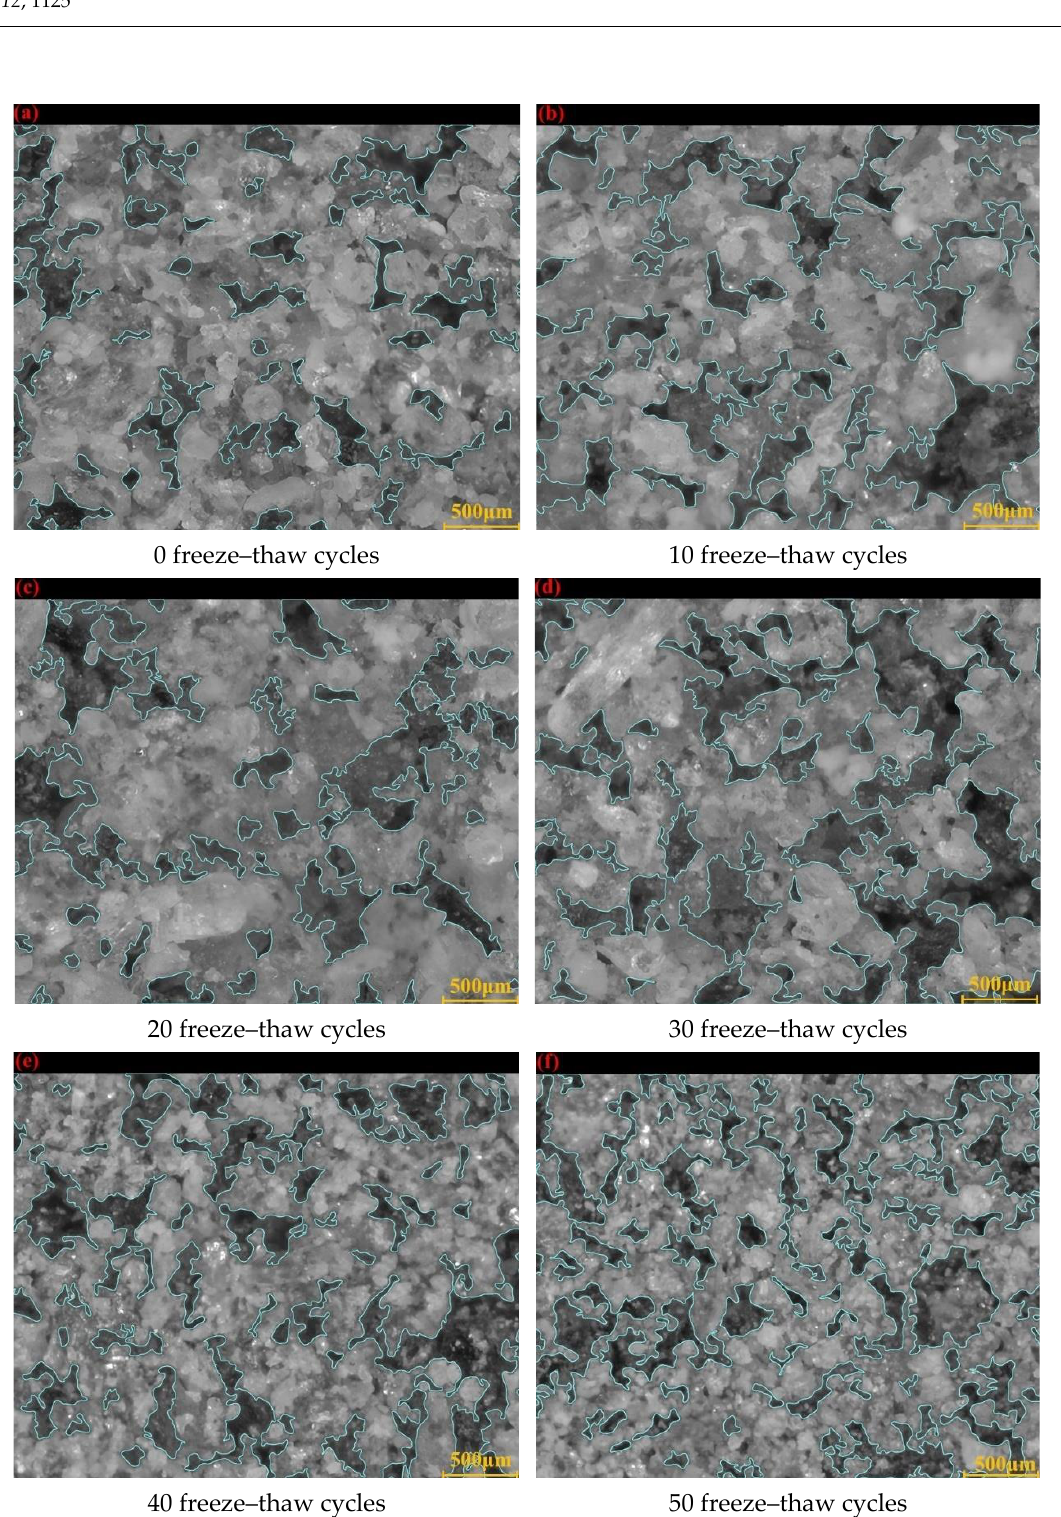
Figure 6. Pore distribution of lower tailings with different freeze – thaw cycles: ( a ) 0 freeze – thaw cycles; ( b ) 10 freeze – thaw cycles; ( c ) 20 freeze – thaw cycles; ( d ) 30 freeze – thaw cycles; ( e ) 40 freeze – thaw cycles; ( f ) 50 freeze – thaw cycles.